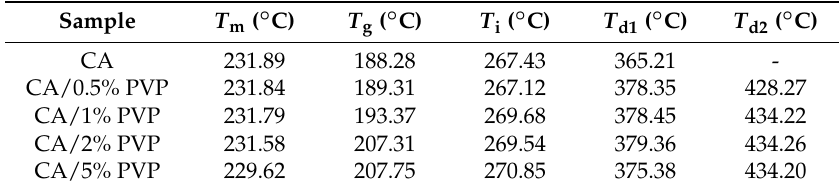
Table 2. TGA curves of CA/PVP hybrid nanofibers analysis results *.